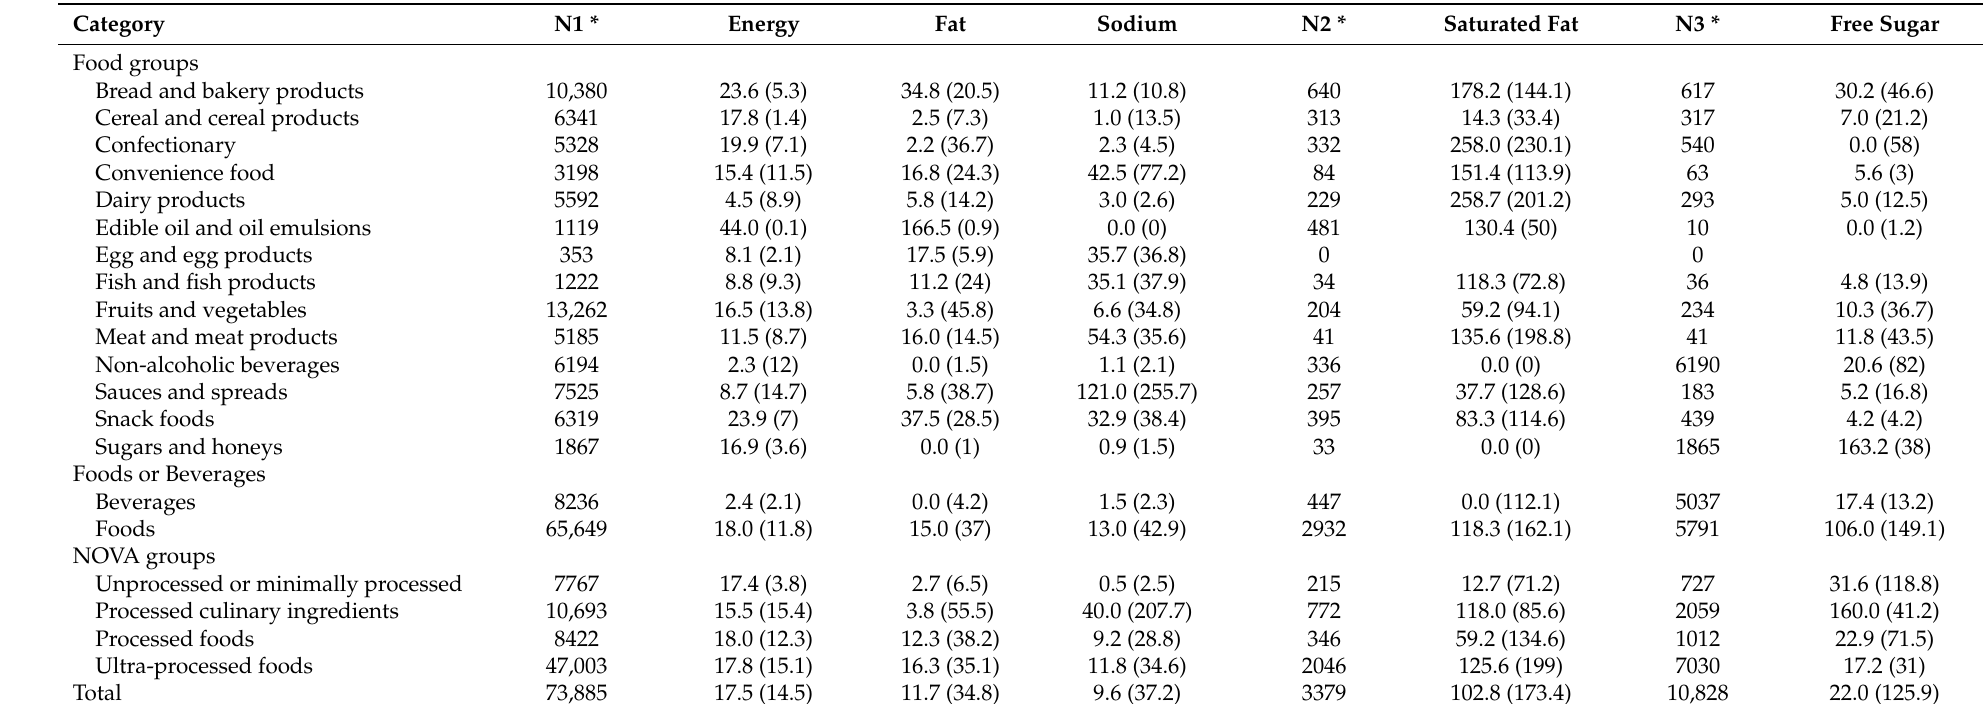
Table 3. Percentage of the nutrient content with China NRV by food categories, median